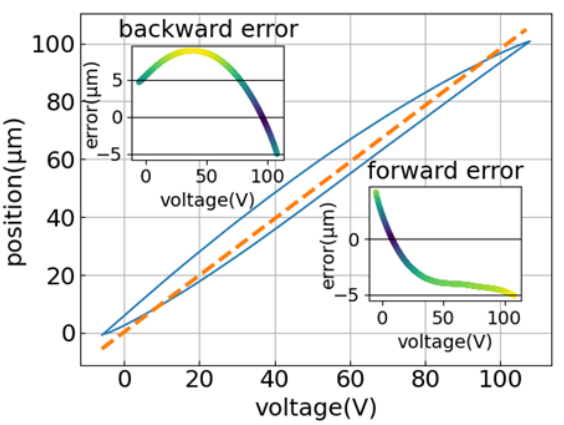
Figure 4. Primary hysteresis loop linear analysis result